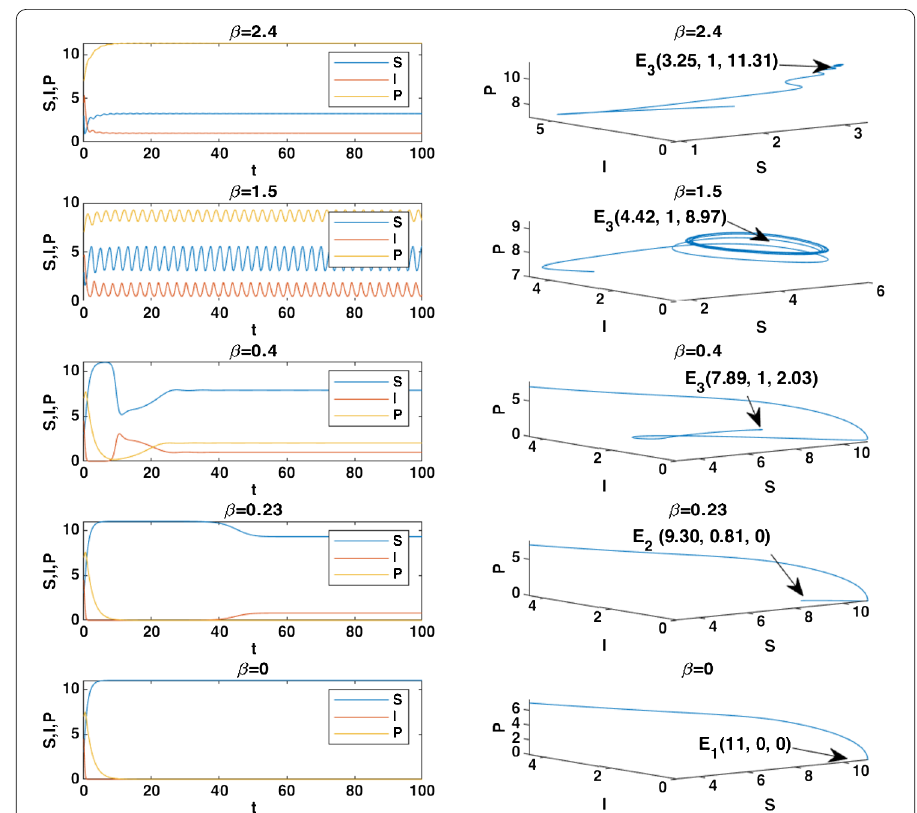
Figure 4 Time series and phase diagram of model (3) with different values of β and q = 1